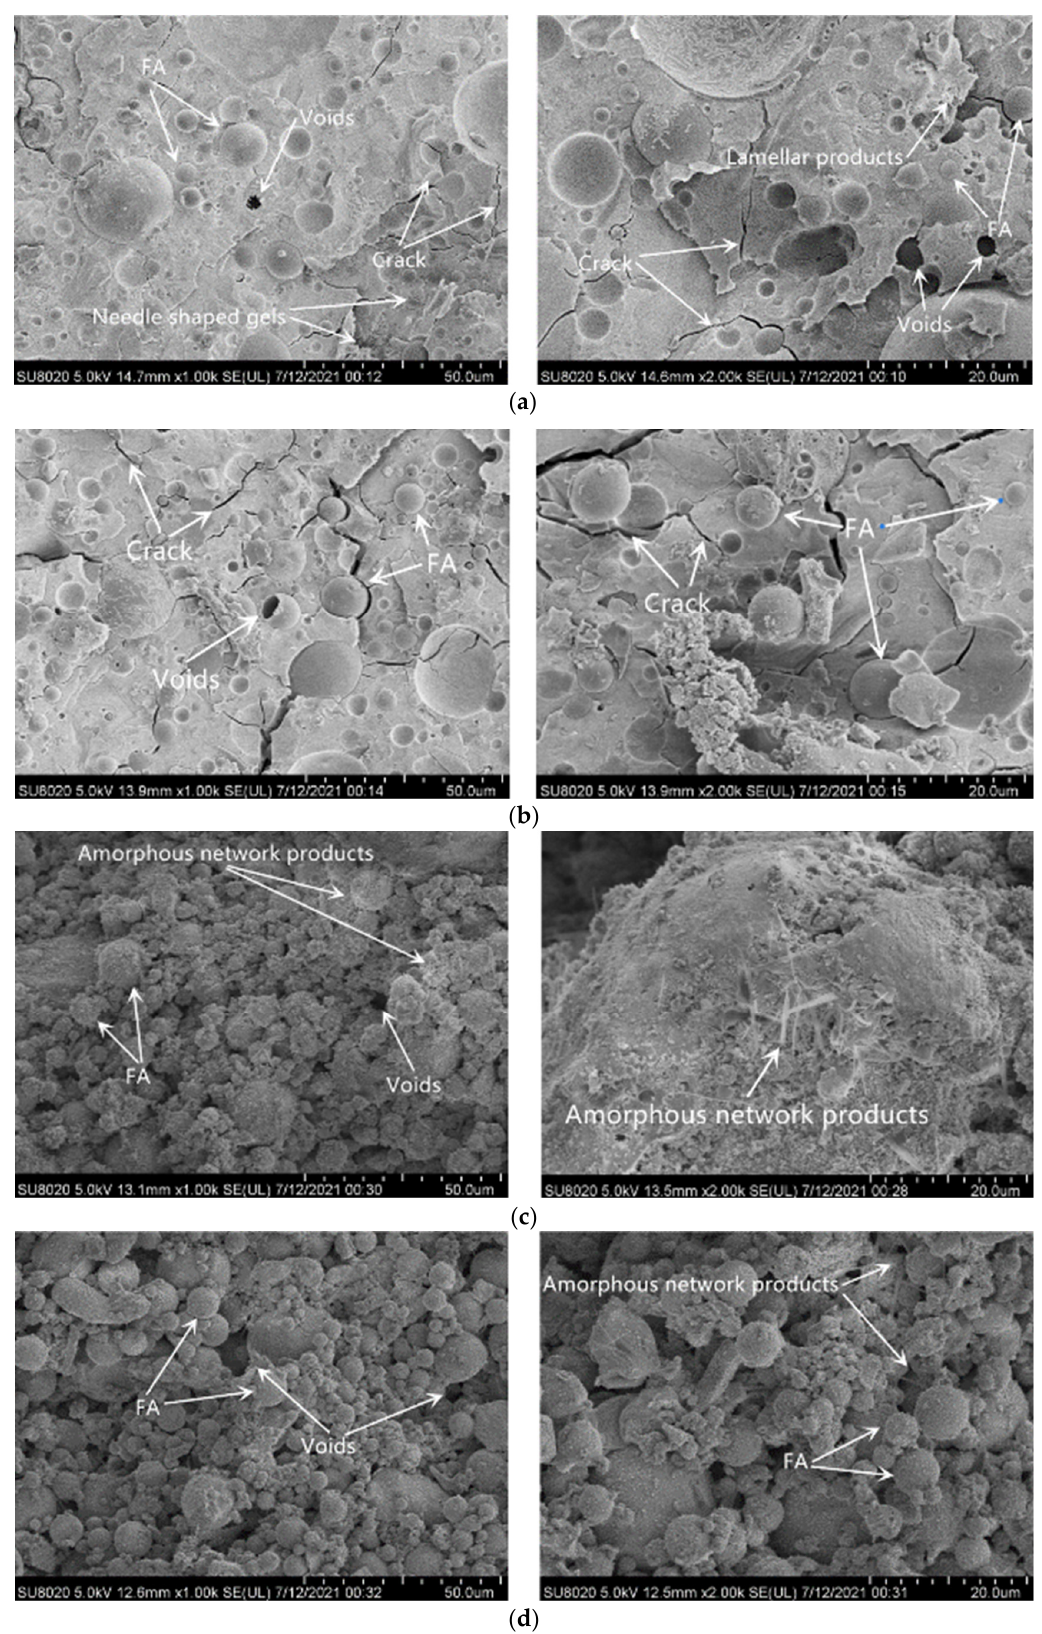
Figure 6. SEM image of 28 d specimen. ( a ) Group 2 samples, ( b ) Group 3 samples, ( c ) Group 15 samples, ( d ) Group 16 samples. ( d ) Group 16